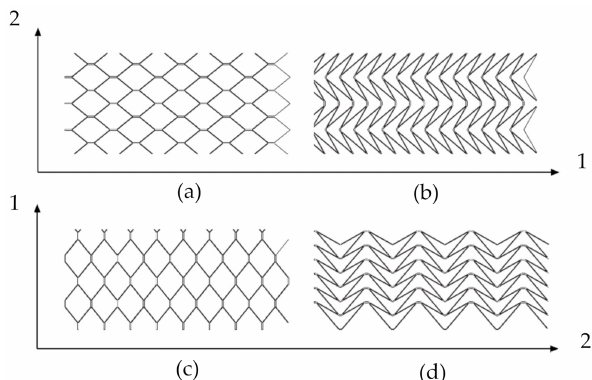
Figure 3. Orthotropy directions of panels: parallel for hexagonal HEX-1 ( a ) and auxetic cores AUX-1 ( b ) and perpendicular for hexagonal HEX-2 ( c ) and auxetic AUX-2 cores ( d